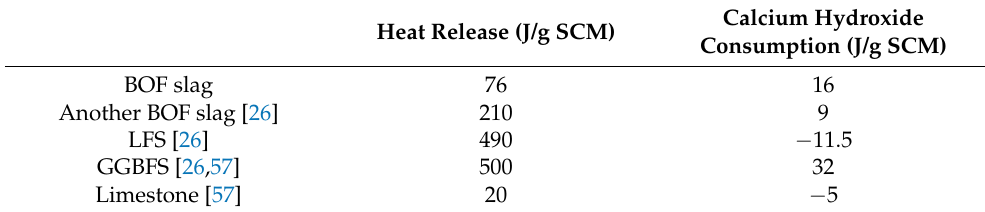
Table 3. Results of modified R 3 reactivity